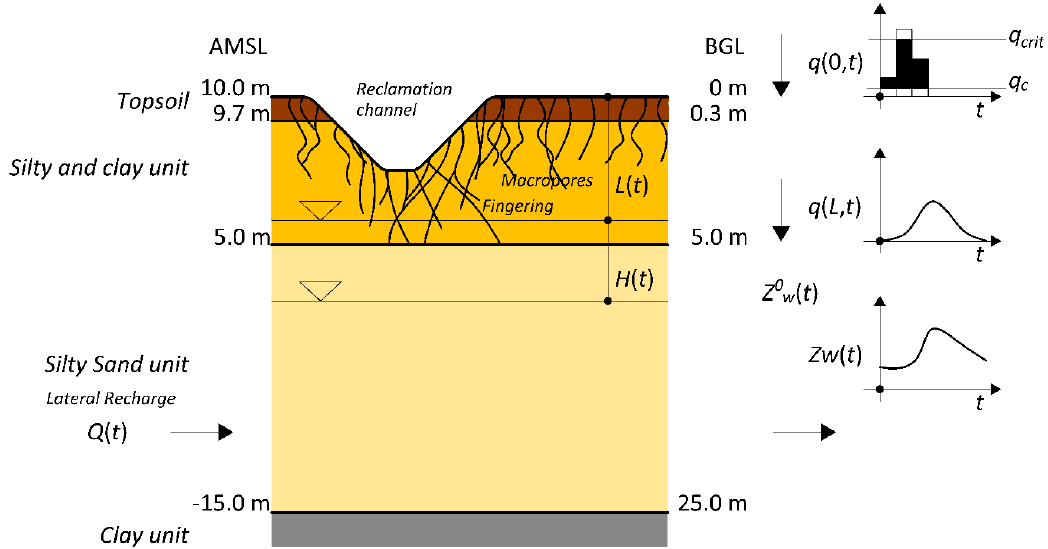
Figure 5. Summary of conceptual model to represent the infiltration processes. L ( t ) is the water table depth, H ( t ) is the height of groundwater level above the base level Z 0w , q (0, t) is the infiltration rate for the topsoil, q ( L , t ) is the infiltration rate for the water table, q c is the infiltration capacity of the topsoil, q crit is the critical value of the infiltration rate.